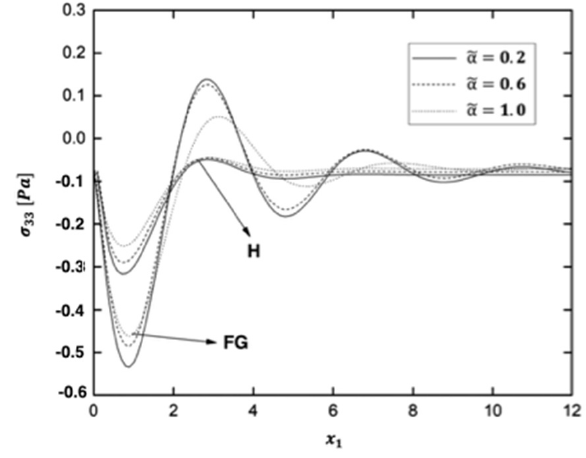
Figure 7. Variation of the thermal stress wave σ 33 along x 1 –axis in the functionally graded (FG) and homogeneous (H) anisotropic fiber-reinforced plates under different fractional order parame- ters.